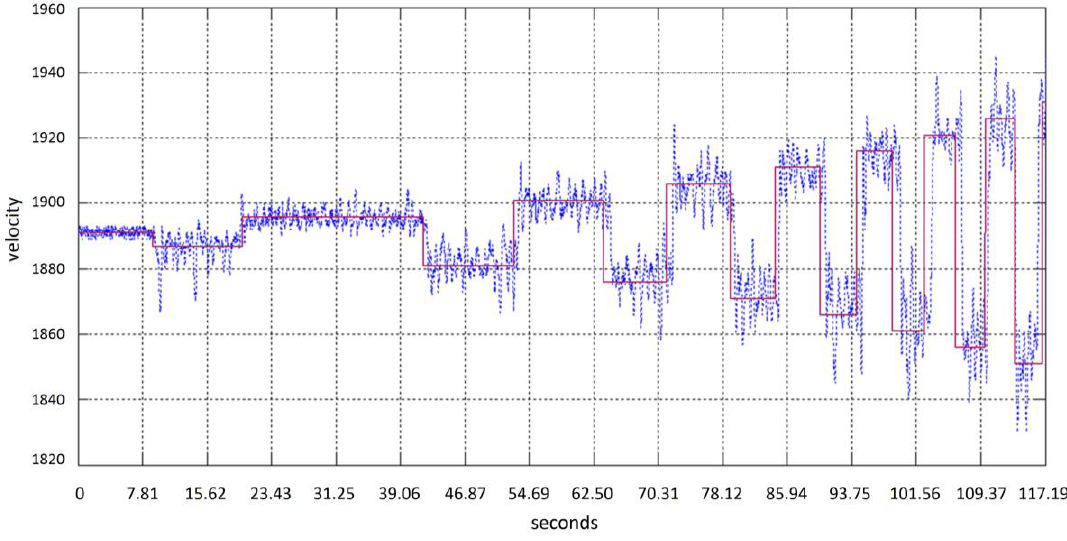
Figure 9. Gyroscope data and velocity target movement from subject head movement; target movement (red line), head movement (blue line).